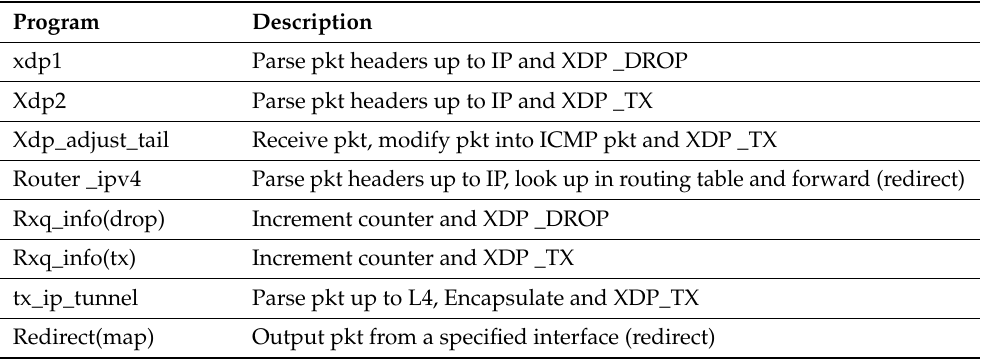
Table 3. Evaluation of test in express data